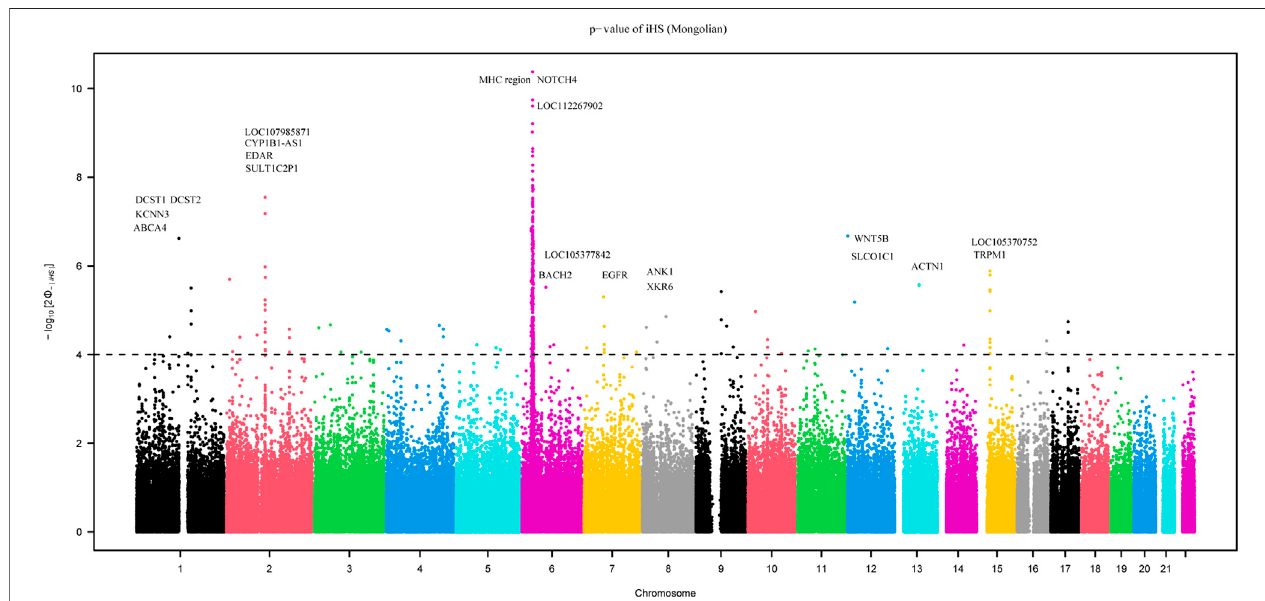
FIGURE 5 | The result of recent natural signatures of positive selective sweeps in Mongolian population based on iHS showed the strongest positive selection region in MHC region.